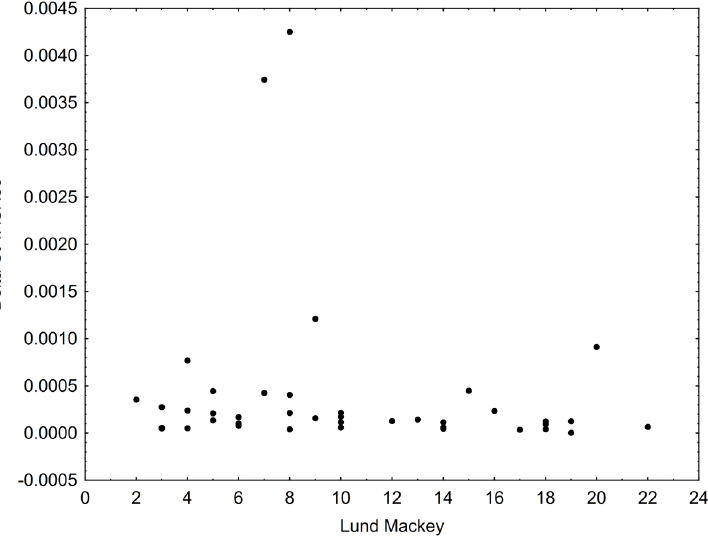
Figure 3. Relation between level of TAS2R38 expression in inferior turbinate mucosa and Lund– Mackay score. Spearman R = − 0.28; p = 0.068.